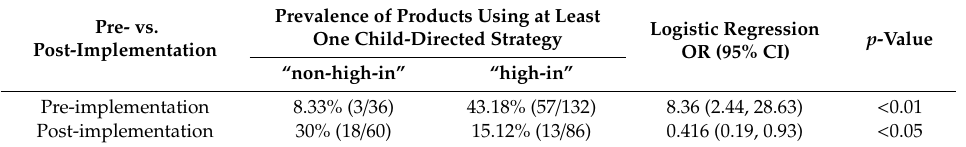
Table 4. Likelihood of breakfast cereal packages featuring child-directed marketing strategies pre- and